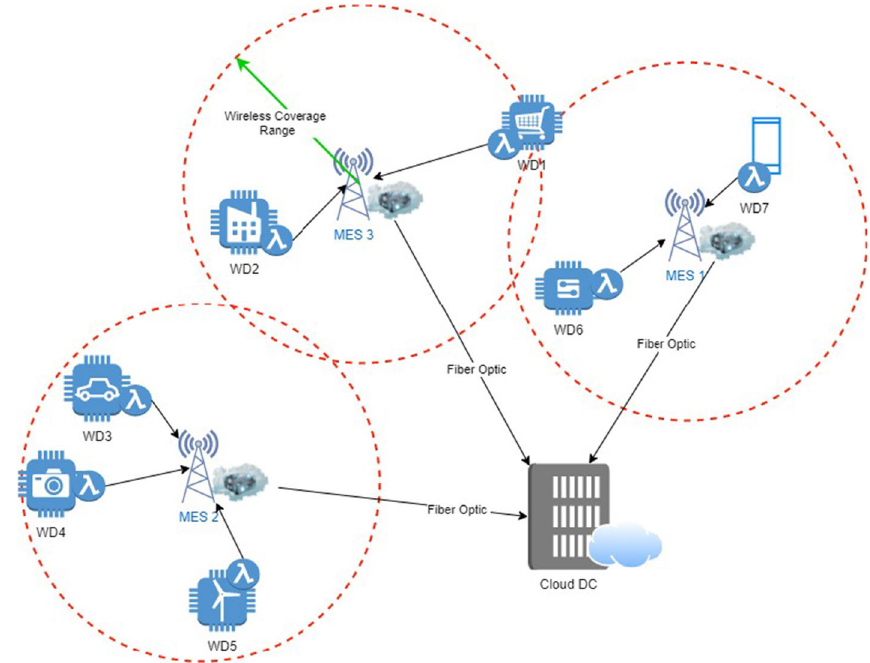
Fig. 1 Mobile edge computing